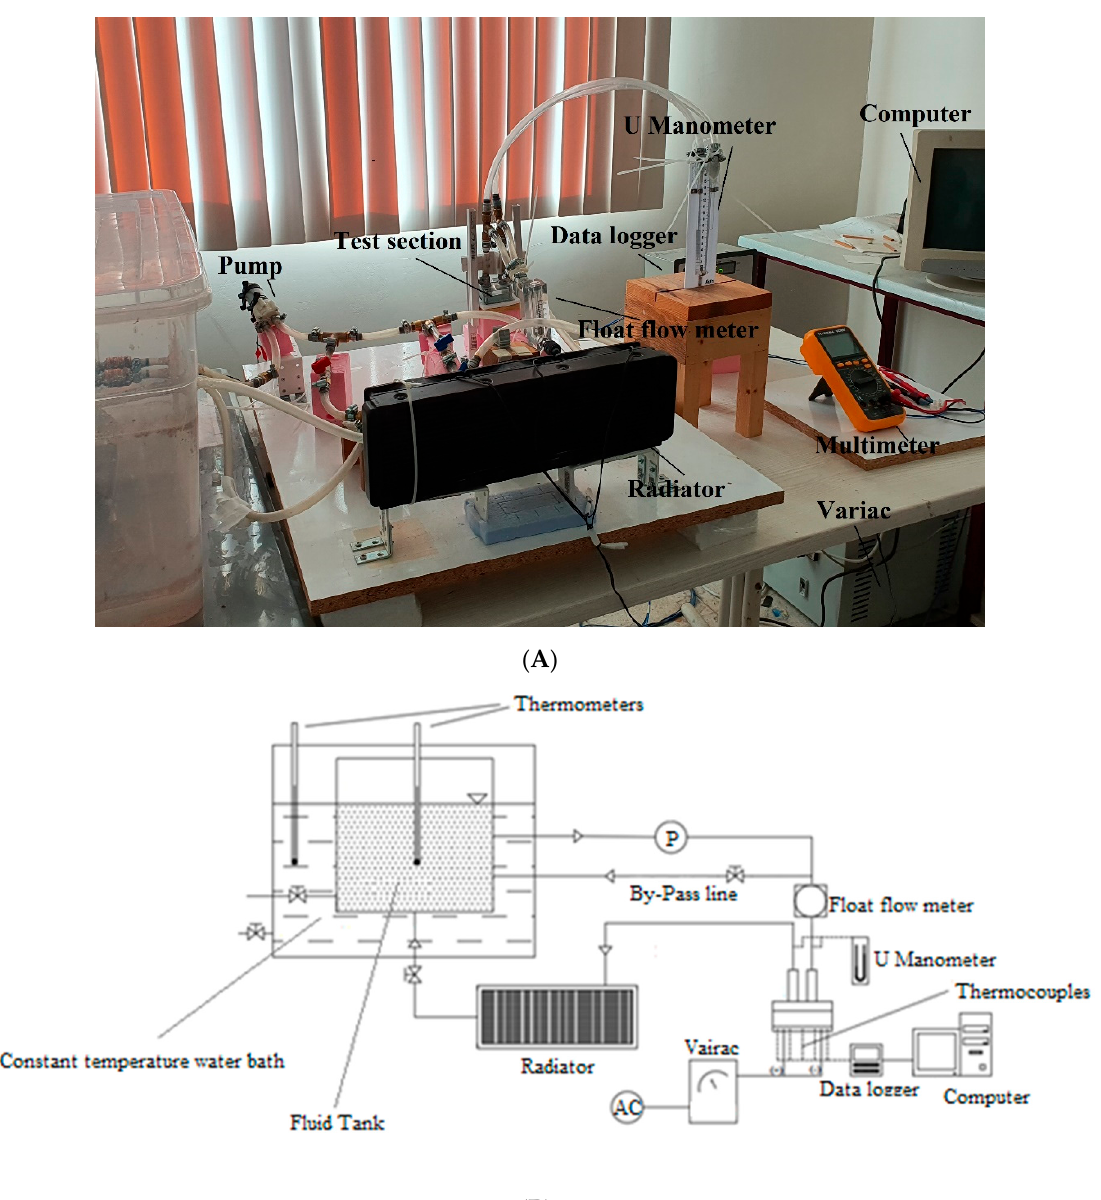
Figure 1. Picture ( A ) and schematic ( B ) of the experimental layout.